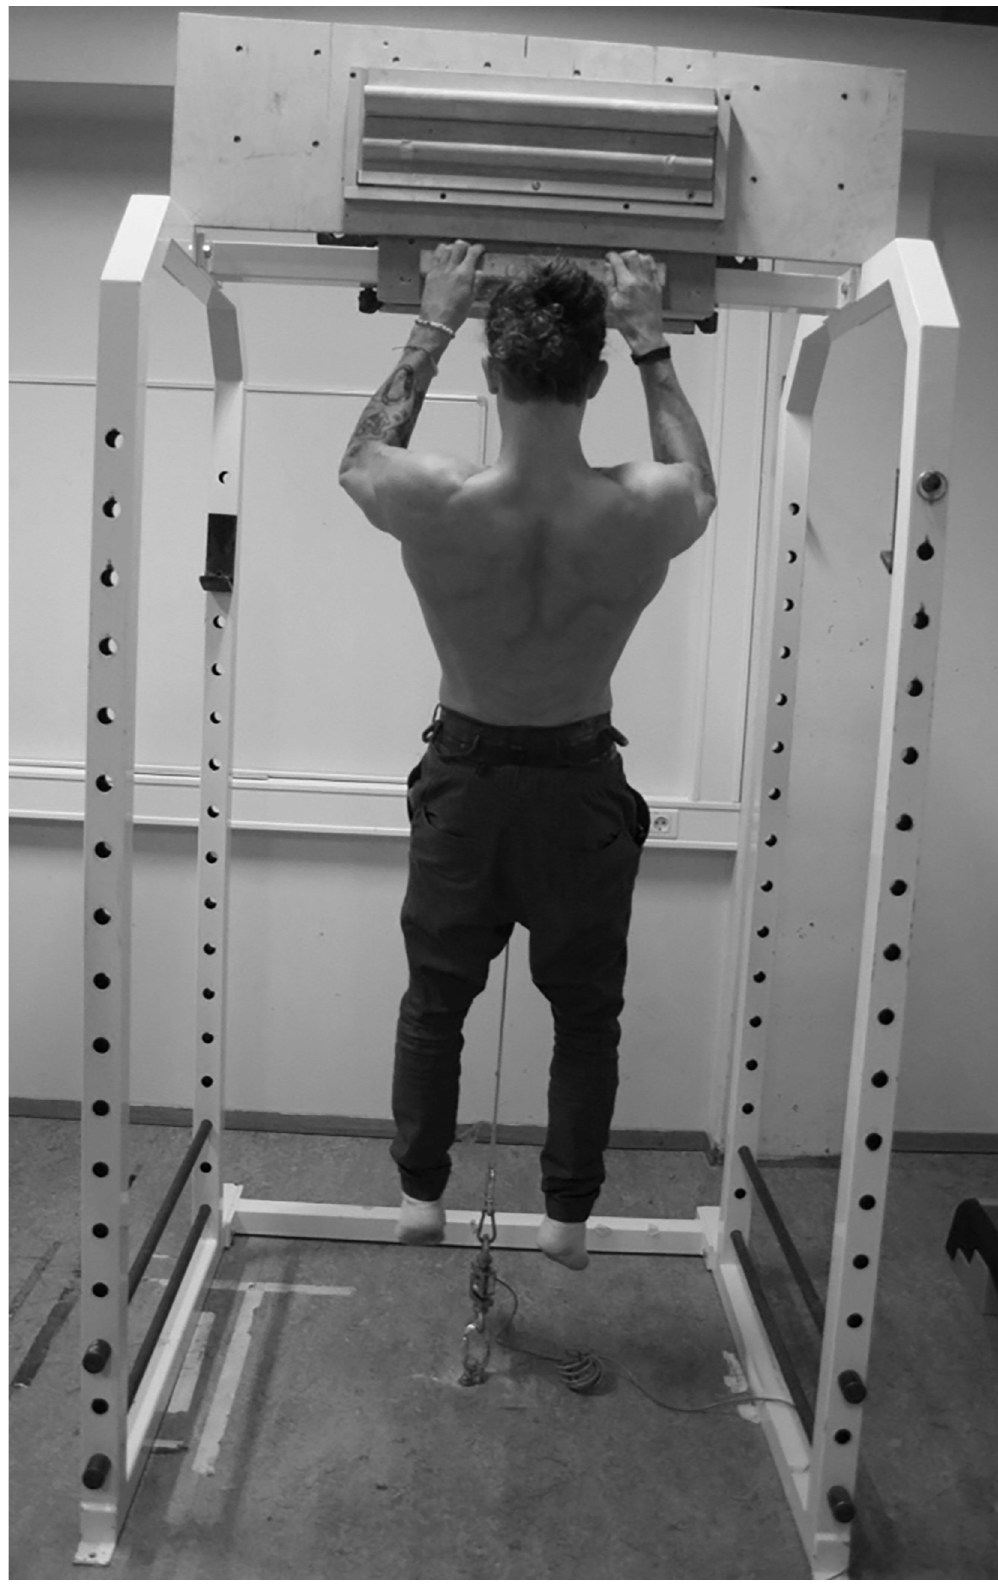
Fig 1. Position with 90 degrees elbow flexion for the isometric pull-up. https://doi.org/10.1371/journal.pone.0222529.g001 PLOS ONE | https://doi.org/10.1371/journal.pone.0222529 September 19,